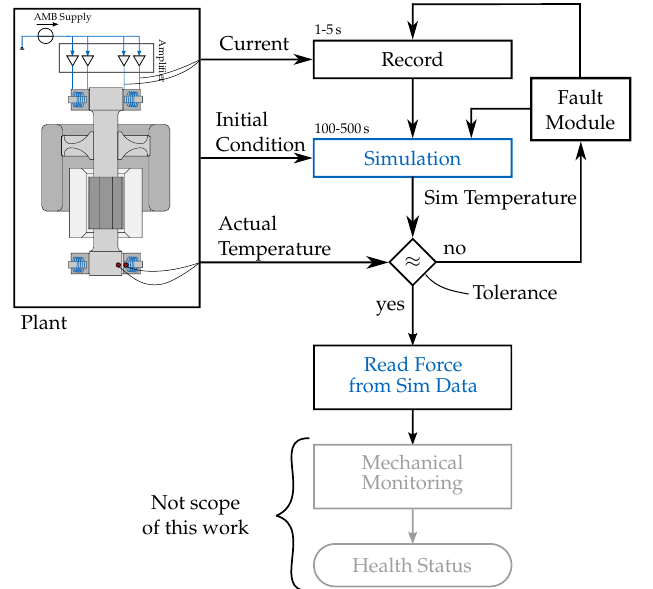
Figure 2. Monitoring scheme for the AMB. The simulation is fed with the measured currents and simulates the magnetic bearing. A comparison of the measured temperature with the simulated temperature gives a hint whether the simulation matches reality and therefore can be trusted.